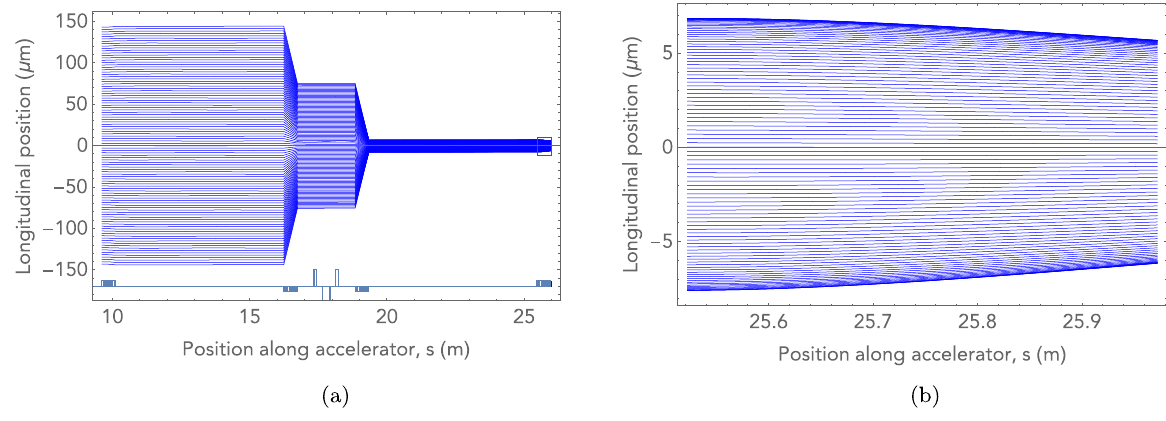
FIG. 8. Electron trajectories (in s – z space) through a bunch compressor. (b) shows a close up of the trajectories through the fourth dipole [i.e., region outlined with a red box in (a)]. Caustics can be seen forming at head and tail of the bunch in (b).